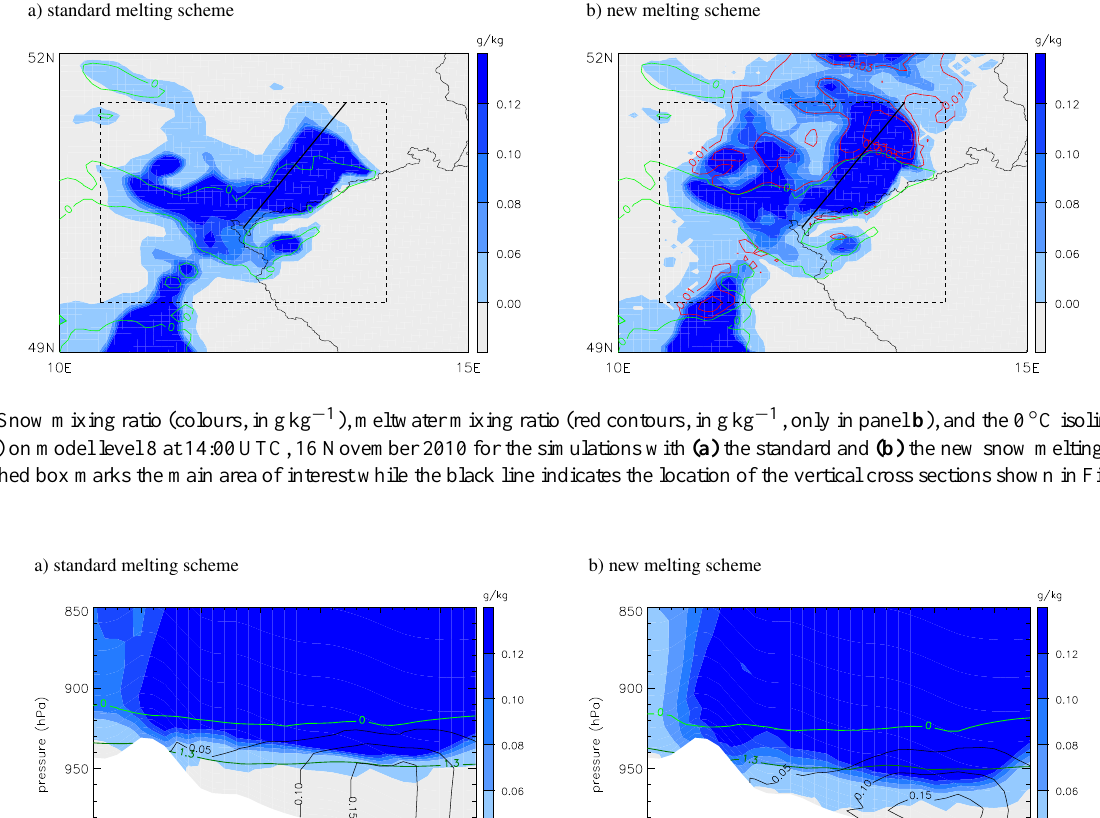
Fig. 6. Vertical section across the snowfall region in eastern Germany at 14 UTC 16 November 2010 (along the green line shown in Fig. 5). Shown are snow mixing ratio (colors, in gkg − 1 ), rain mixing ratio (black lines, in gkg − 1 ), the 0 ◦ C isoline (green), and the isoline of 1 . 3 ◦ C wet bulb temperature (dark green) for the simulations with (a) the standard and (b) the new snow melting scheme. i.e., at levels below the level of maximum snow meltwater mixing ratio, the snow to rain conversion becomes more ef- ficient and both the snow and meltwater mixing ratios start to decrease, while the liquid water fraction of the snow still increases due to ongoing melting.